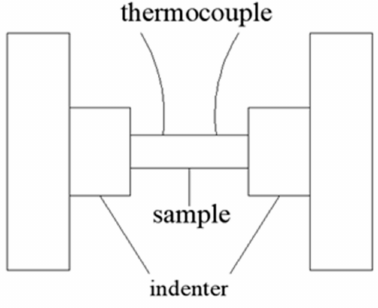
Figure 2. Schematic diagram of hot